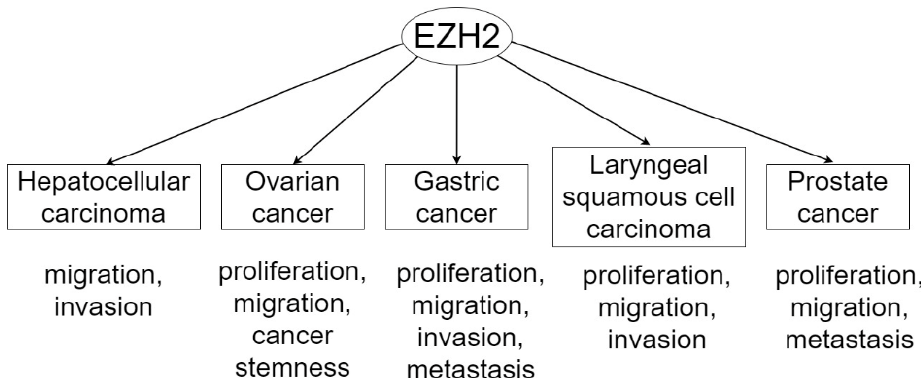
Figure 5. The role of EZH2 in the biological processes of carcinogenesis in five epithelial cancers.